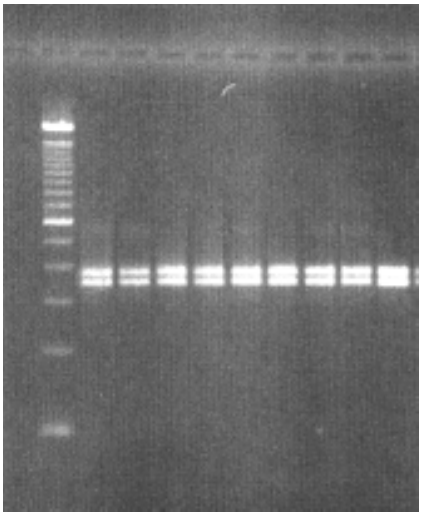
Fig. 1. Fragment lengths (bp) after endonuclease diges- tion with Hinf I of the ITS regions including the 5.8S rDNA of Rhizoctonia solani isolates. From left to right: 100 bp DNA Ladder, R0297, R2297, R0397, R1397, R0497, R1497, R2497, R1697, TC1.